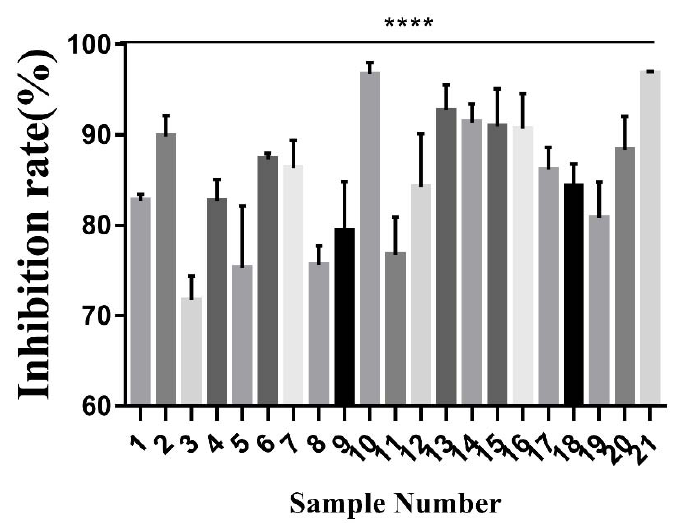
Figure 3. In vitro anticancer activities of 21 batches of toad venom extracts (A549 cells were incubated